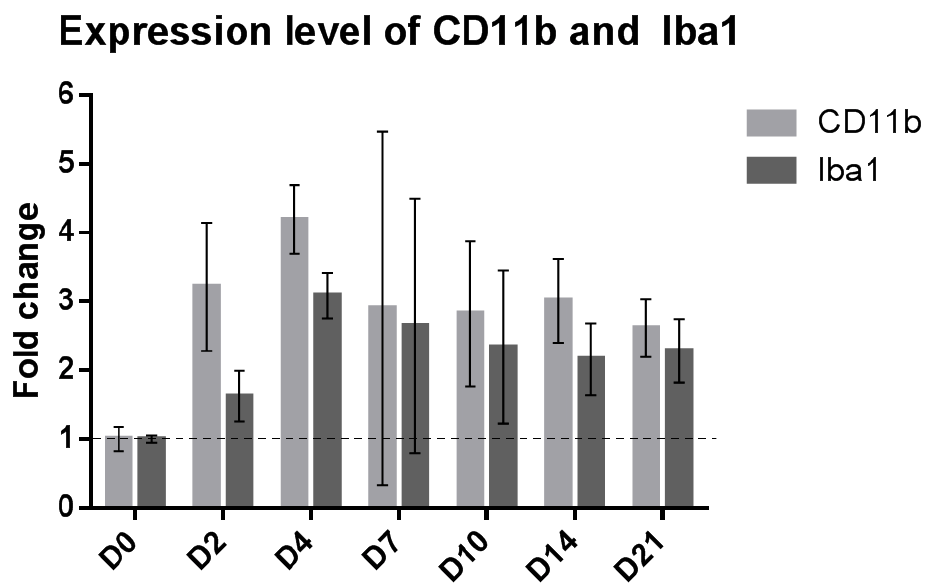
Figure 1. Upregulation of microglial markers after SNI. Bar graph showing the mRNA fold change in rat ipsilateral dorsal horns of the microglial markers CD11b (light gray) and Iba1 (dark gray) compared to naive animals. Values are expressed as mean ± 95% CI. N = 3 for each time point.